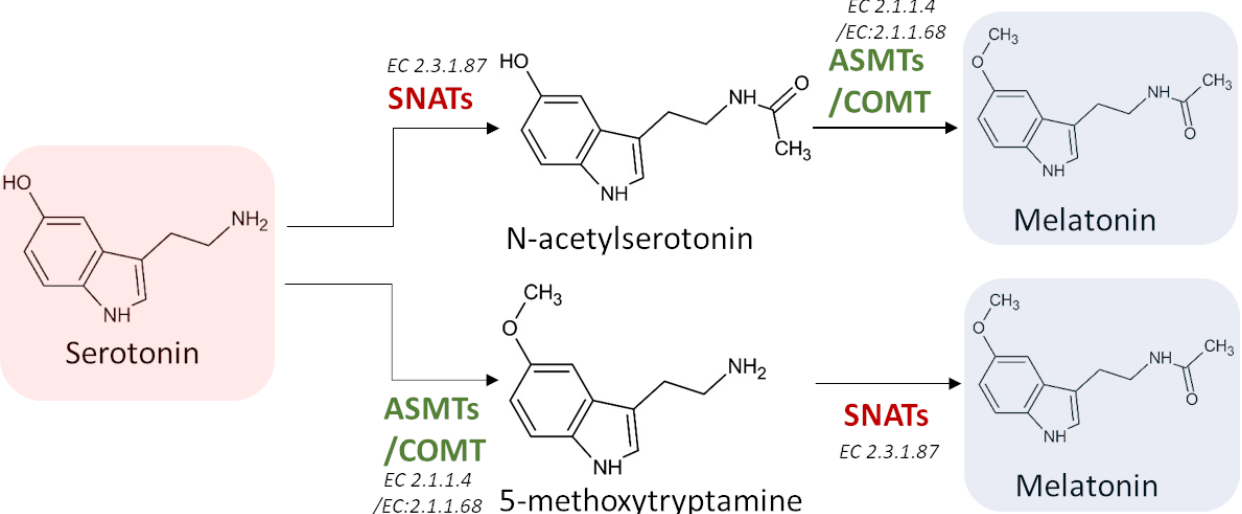
Figure 5. The last two potential reactions leading to the formation of melatonin. SNATs: serotonin N-acetyltransferase; ASMTs: acetylserotonin O-methyltransferase; COMT: caffeic acid 3-O-methyltransferase; EC: enzyme commission num- ber.